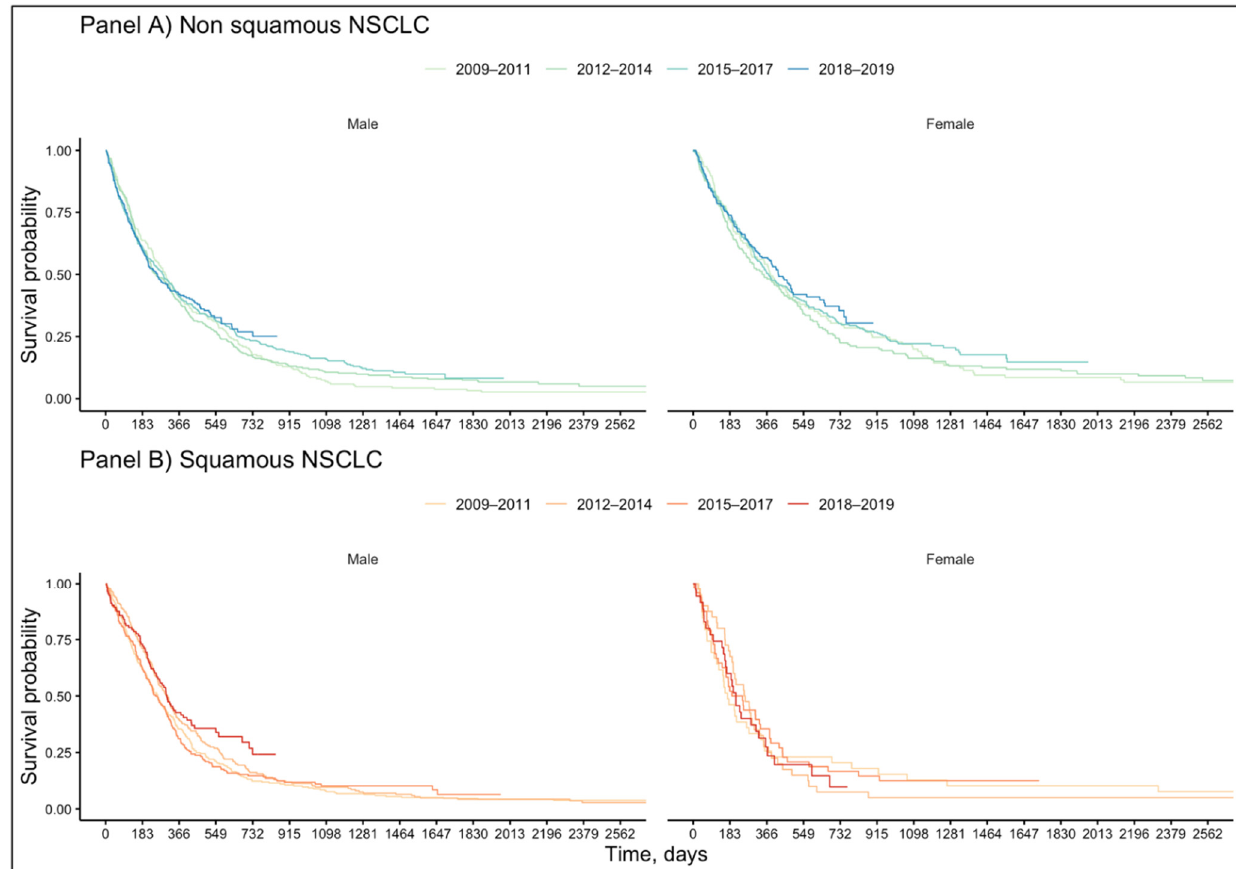
Figure 4. Gender-related survival of patients with non-squamous and squamous NSCLC treated with first-line pharmacotherapy. Panel ( A ): non-squamous NSCLC patients; panel ( B ) squamous NSCLC.